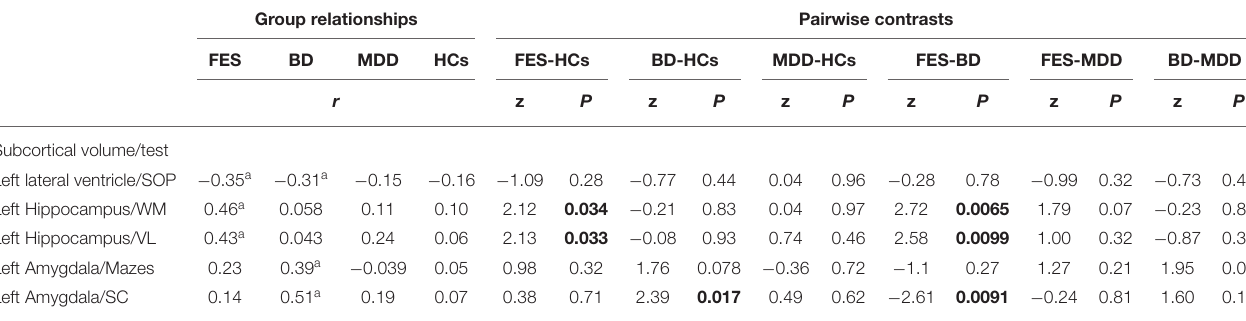
TABLE 2 | Pairwise contrasts of correlations between subcortical volumes and neurocognitive tests. Group relationships Pairwise contrasts FES BD MDD HCs FES-HCs BD-HCs MDD-HCs FES-BD FES-MDD BD-MDD r z P P z P z